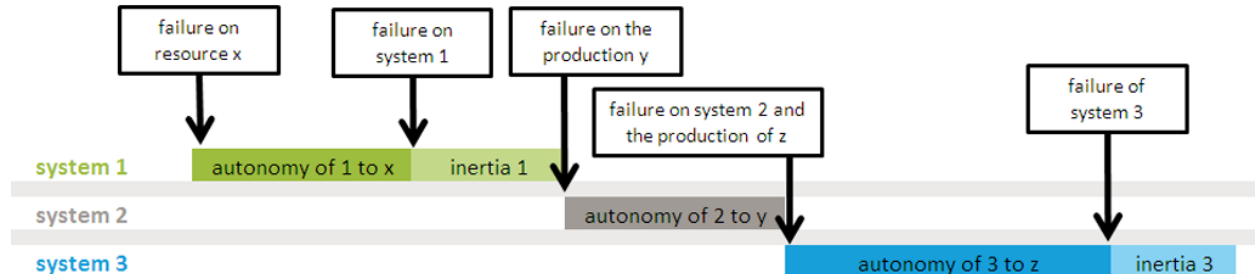
Fig. 3. Cascading failures between 3